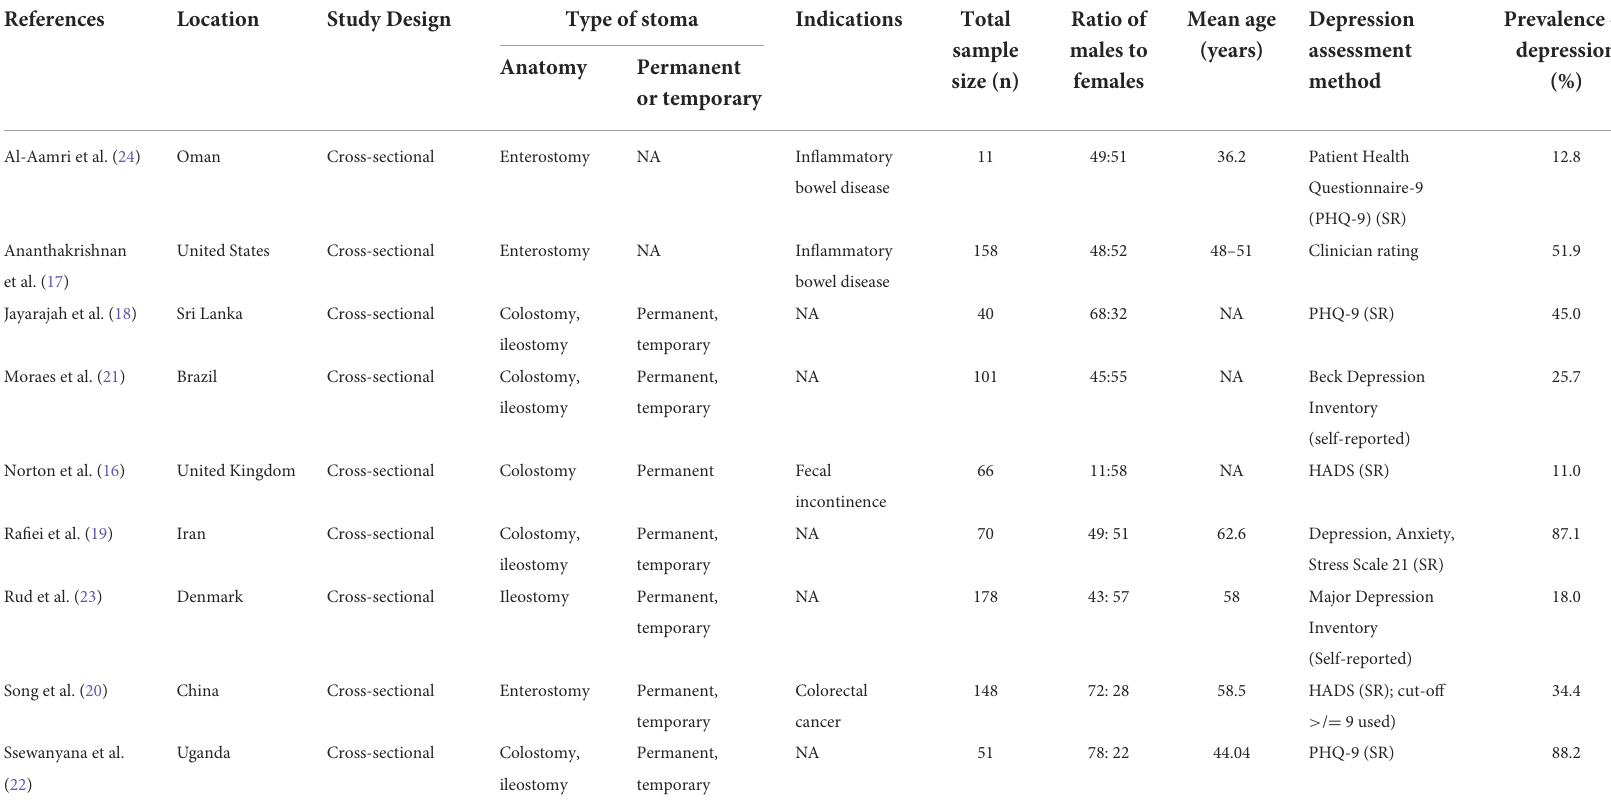
TABLE 1 Characteristics of the included